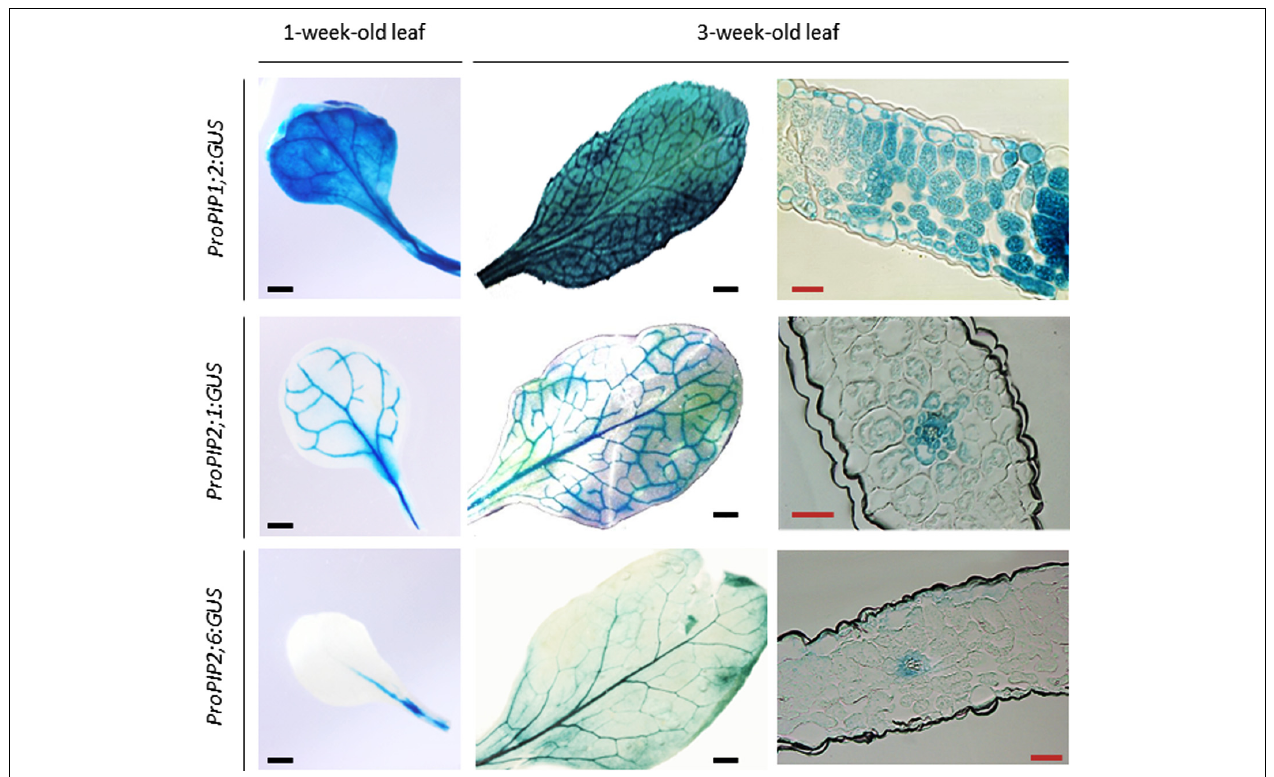
AQP isoforms ( At PIP1;2, At PIP2;1, At PIP2;6) contribute to rosette hydraulic conductivity (Prado etal., 2013). Cross-sections show intense staining in the veins of each type of transgenic plants (black scale bar = 2.5 mm, red scale bar = 0.1